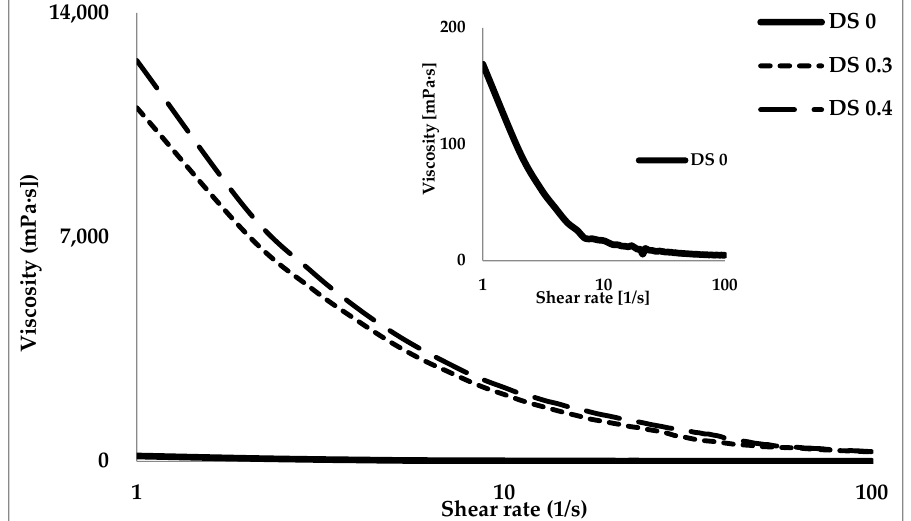
Figure 4. Different viscosity from different DS − treated green waste biomass.